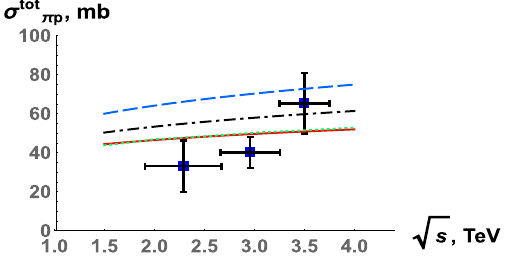
Fig. 3 Rescattering corrections multiplied by formfactors for 7 TeV ( ˜ S ( s , ξ) ) integrated in the whole t regions of the LHCf data [19]: η > 10 . 76. Dotted vertical lines mark ξ = 0 . 107 , 0 . 179 , 0 . 25, which are used to extract σ π p cross-sections